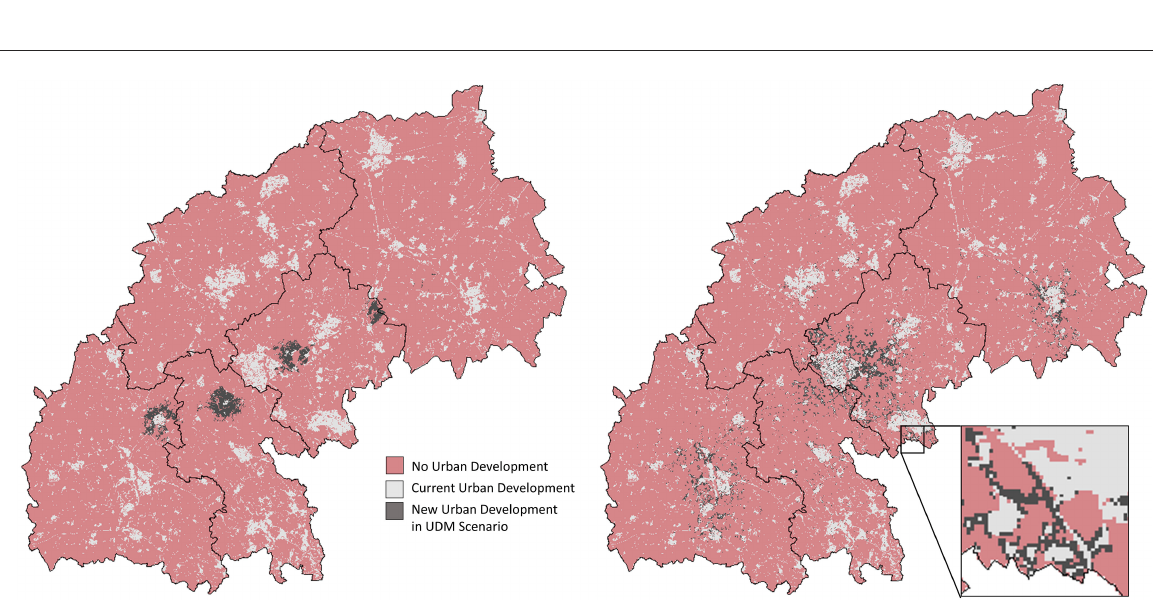
Housing densities for the 1-value and 2-value tiles were then obtained from the UDM. These housing densities were amalgamated into groups of similar values, and a